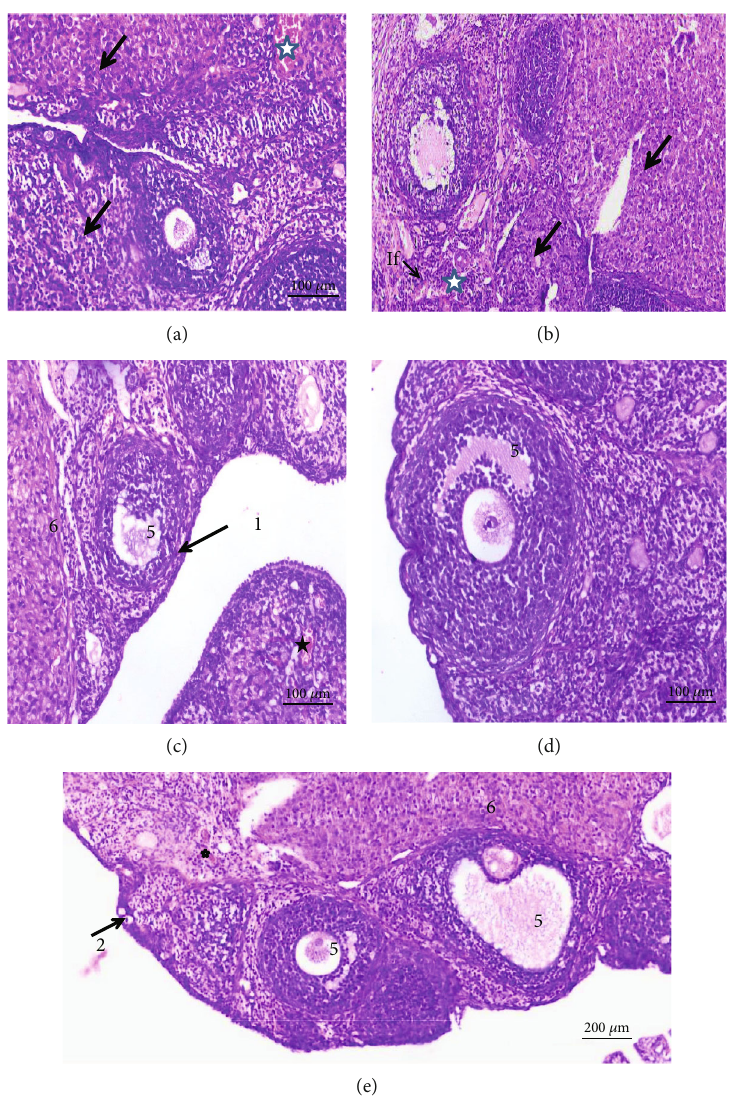
Figure 7: Photomicrographs of rat ovarian sections (a, b) from the RA group showing numerous luteal structures (arrow) in ovarium medulla and hyperemia in the stroma (star); (c – e) from arthritic-treated groups with curcumin, stem cells, and a mixture of curcumin and stem cells, respectively, showing nearly normal histological structure except for a few hyperemic areas in the stroma (star) and mononuclear cell in fi ltration (IF). (1) Germinal epithelium, (2) primordial follicles, (5) mature (antral or Graa fi an) follicle, and (6) corpus luteum